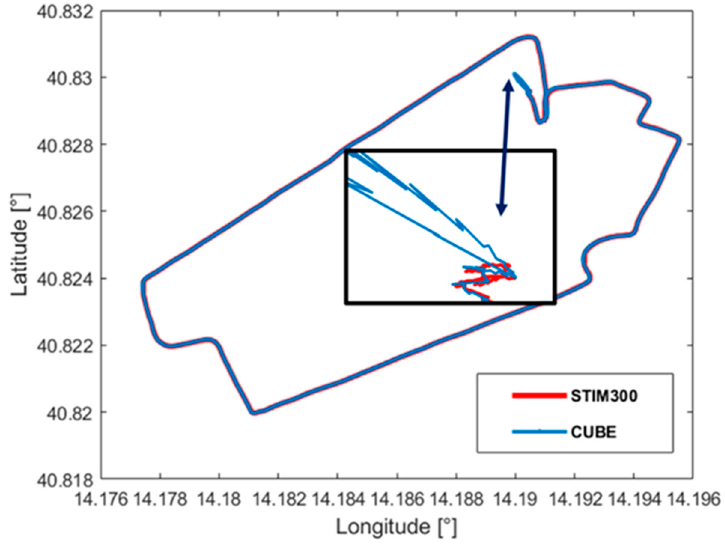
Figure 13. Comparison of position results provided by the proposed prototype and the reference IMU.